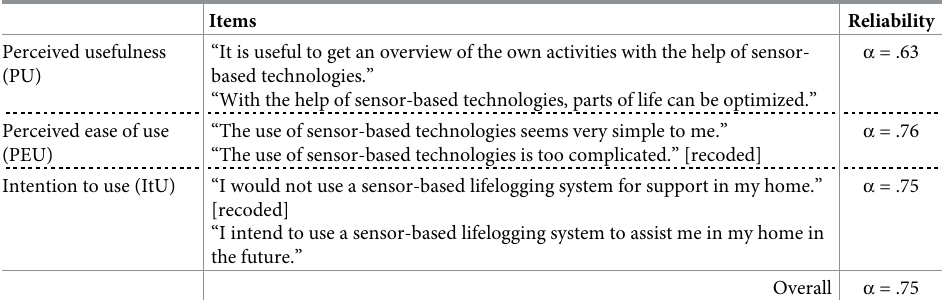
Table 1. Items used for technology acceptance [18] adapted to sensor-based lifelogging technology and the inter- nal consistency (Cronbach’s α ) of the particular